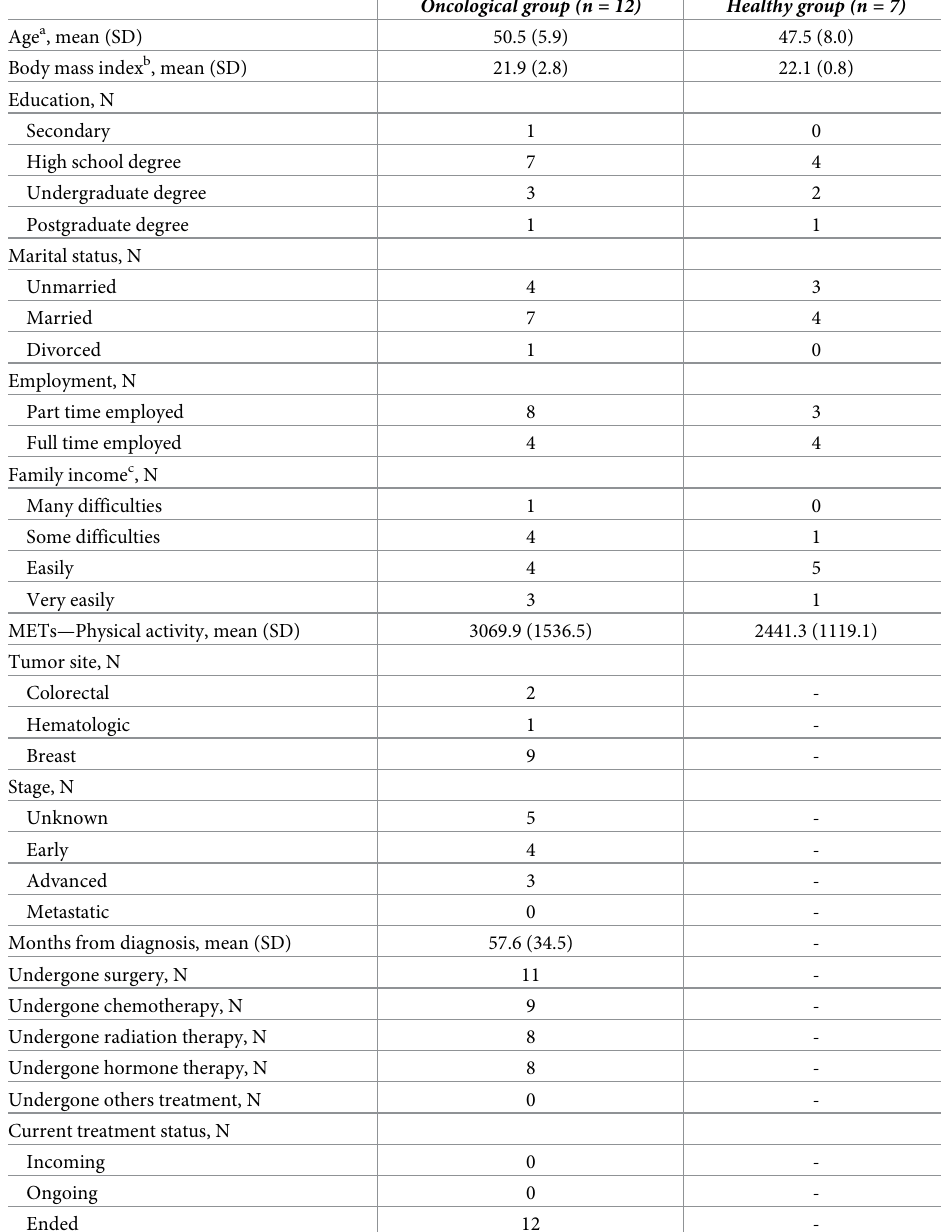
Table 2. Participant’